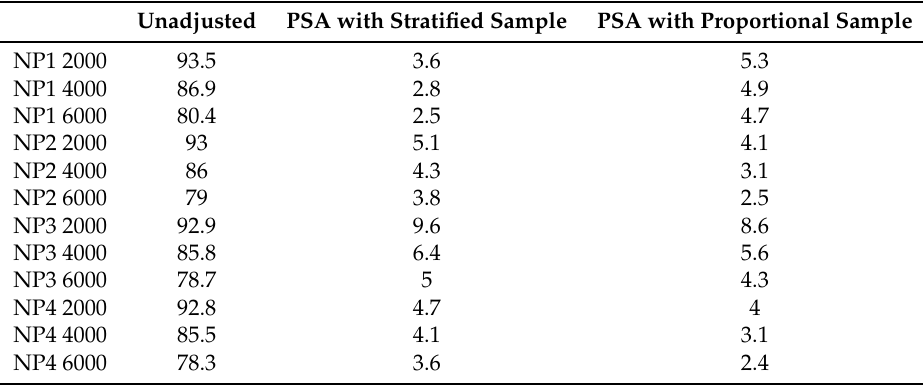
Table 11. Relative RMSE(%) for estimating HCI without and with applying